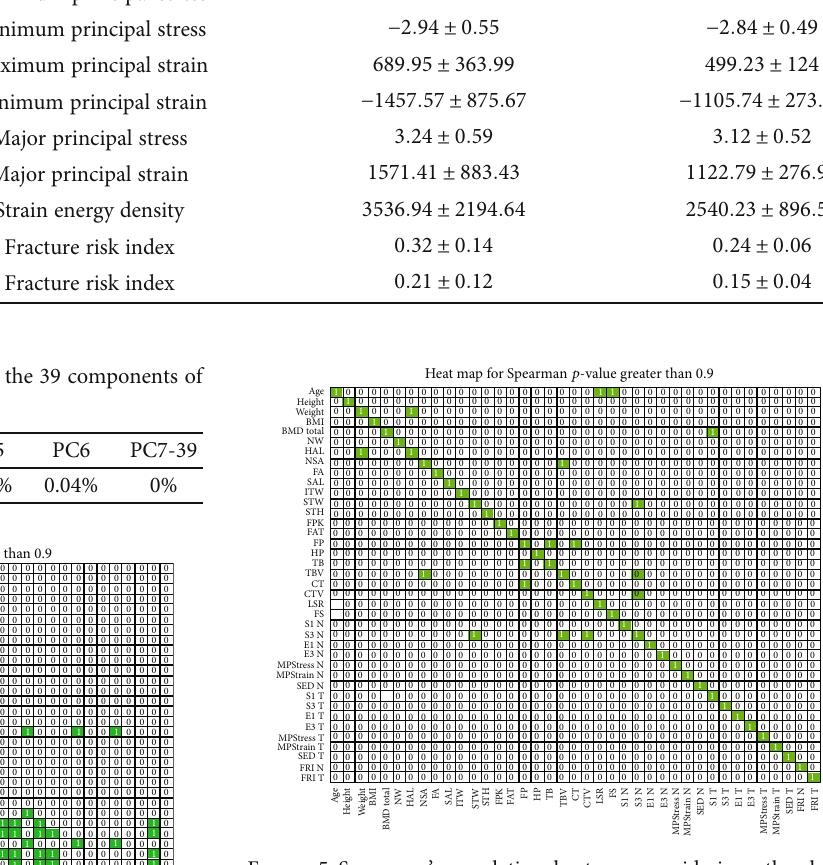
Figure 5: Spearman ’ s correlation: heat map considering a threshold of 2.2.3. Fracture Discrimination. To build the classi fi er, we considered some of the most popular ML approaches: LR, SVM, Decision Trees (DT) and RF. All the models were trained considering that the positive class — coded as 1 — cor- responds with fractured patients and the negative class — - coded as 0 — with control samples. The goodness of the models was assessed by means of sensitivity (Se), speci fi city (Sp), and accuracy (Acc).